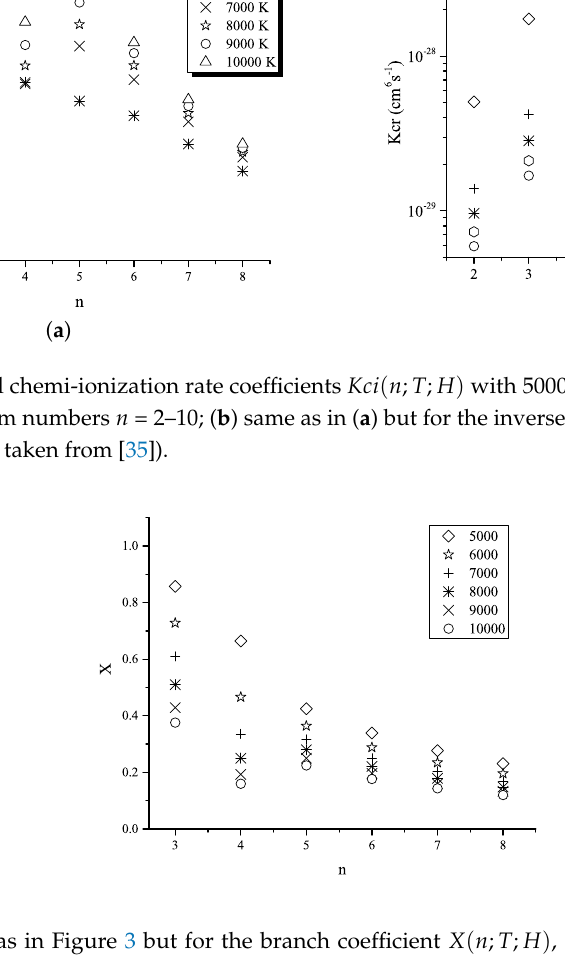
Figure 4. Same as in Figure 3 but for the branch coefficient X ( n ; T ; H ) , characterizing the relative importance of the particular channel (‘a’ and ‘b’) for the chemi-ionization and chemi-recombination processes